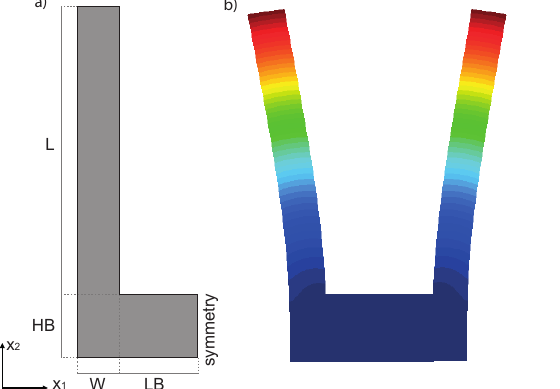
Figure 2. Tuning fork resonator. ( a ) Schematic view of the tuning fork resonator with out of plane thickness t . ( b ) First bending mode of the resonator. The contour of the displacement field is shown in